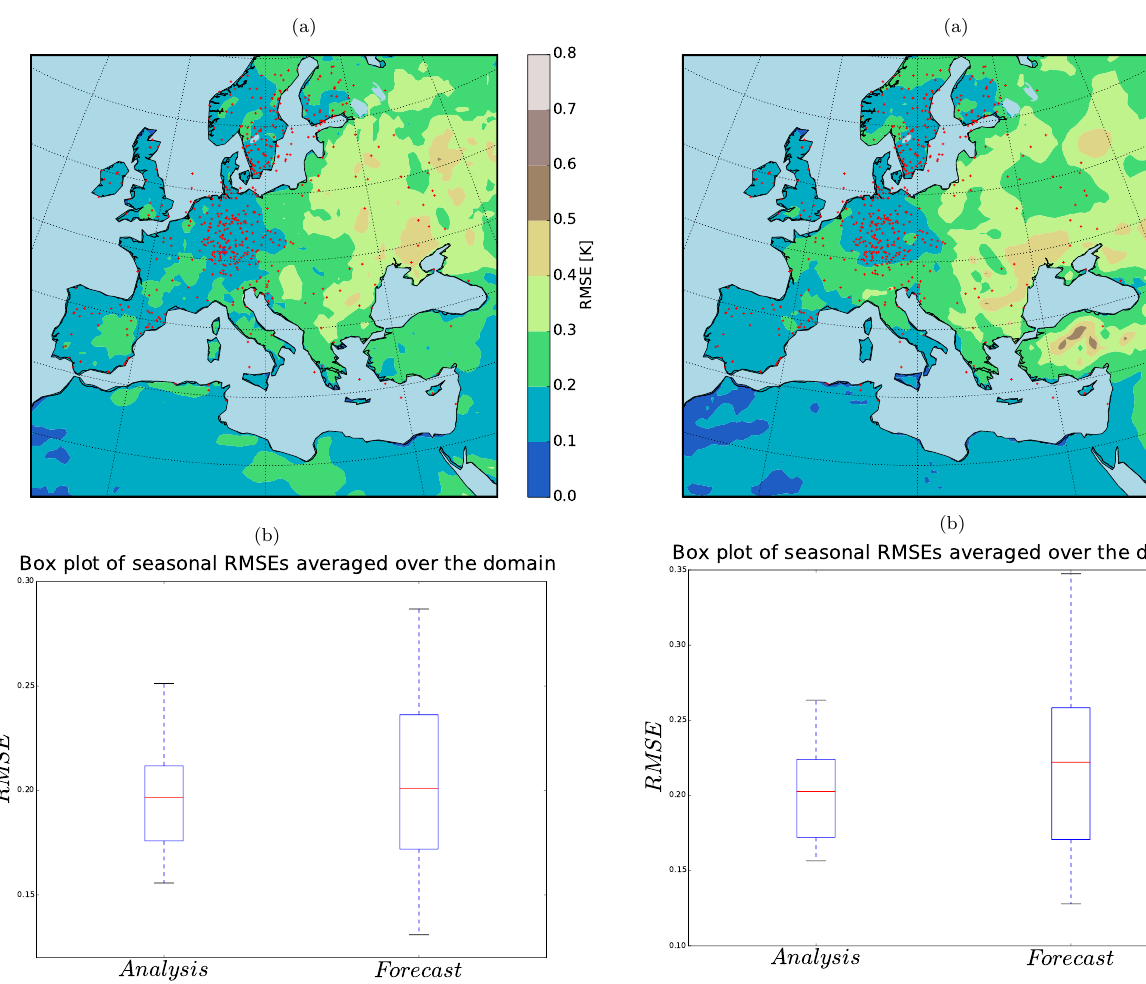
Figure 9. (a) 36-year RMSE (K) of the analysis for winter (DJF) and (b) the field mean RMSE (K) of the analysis and the free ensem- ble run for winter (DJF). Red squares indicate the mean of